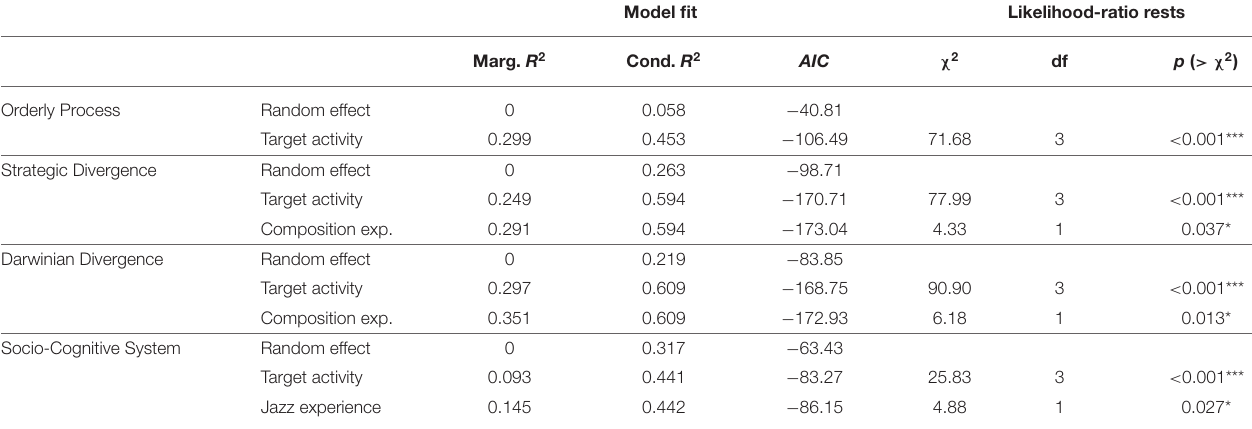
TABLE 2 | Construction of mixed models for the four dimensions of creativity